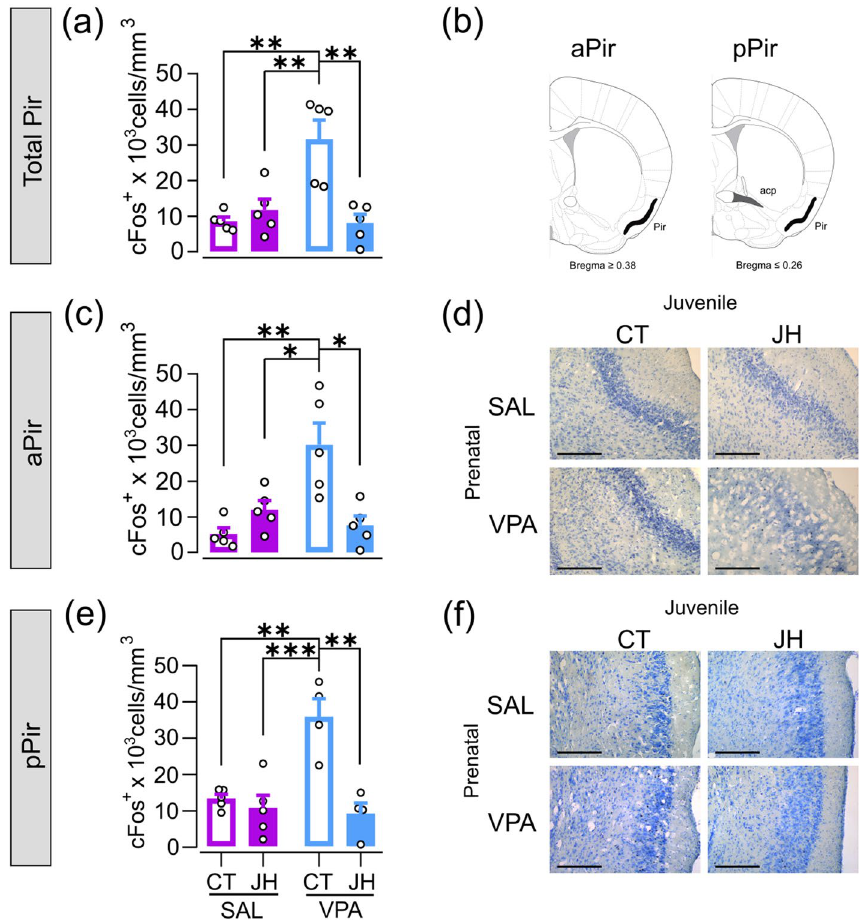
Figure 4. Effect of prenatal VPA and JH on neuronal activity in the piriform cortex (Pir). ( a ) Density of cFos-positive cells in the layer 2 of the Pir is larger in VPA-CT animals when compared with the other groups. ( b ) Scheme showing the limit for the anterior Pir (aPir) and the posterior Pir (pPir). VPA-CT animals show increased cFos-positive cell density in the aPir ( c ) and the pPir ( e ). LME models followed by Tukey’s post hoc comparisons, *p < 0.05. Data are shown as individual values (dots) and mean + s.e.m. N = 4–5 per group. Representative sections subjected to cFos immunohistochemistry and Nissl staining of the aPir ( d ) and pPir ( f ). Bars, 200